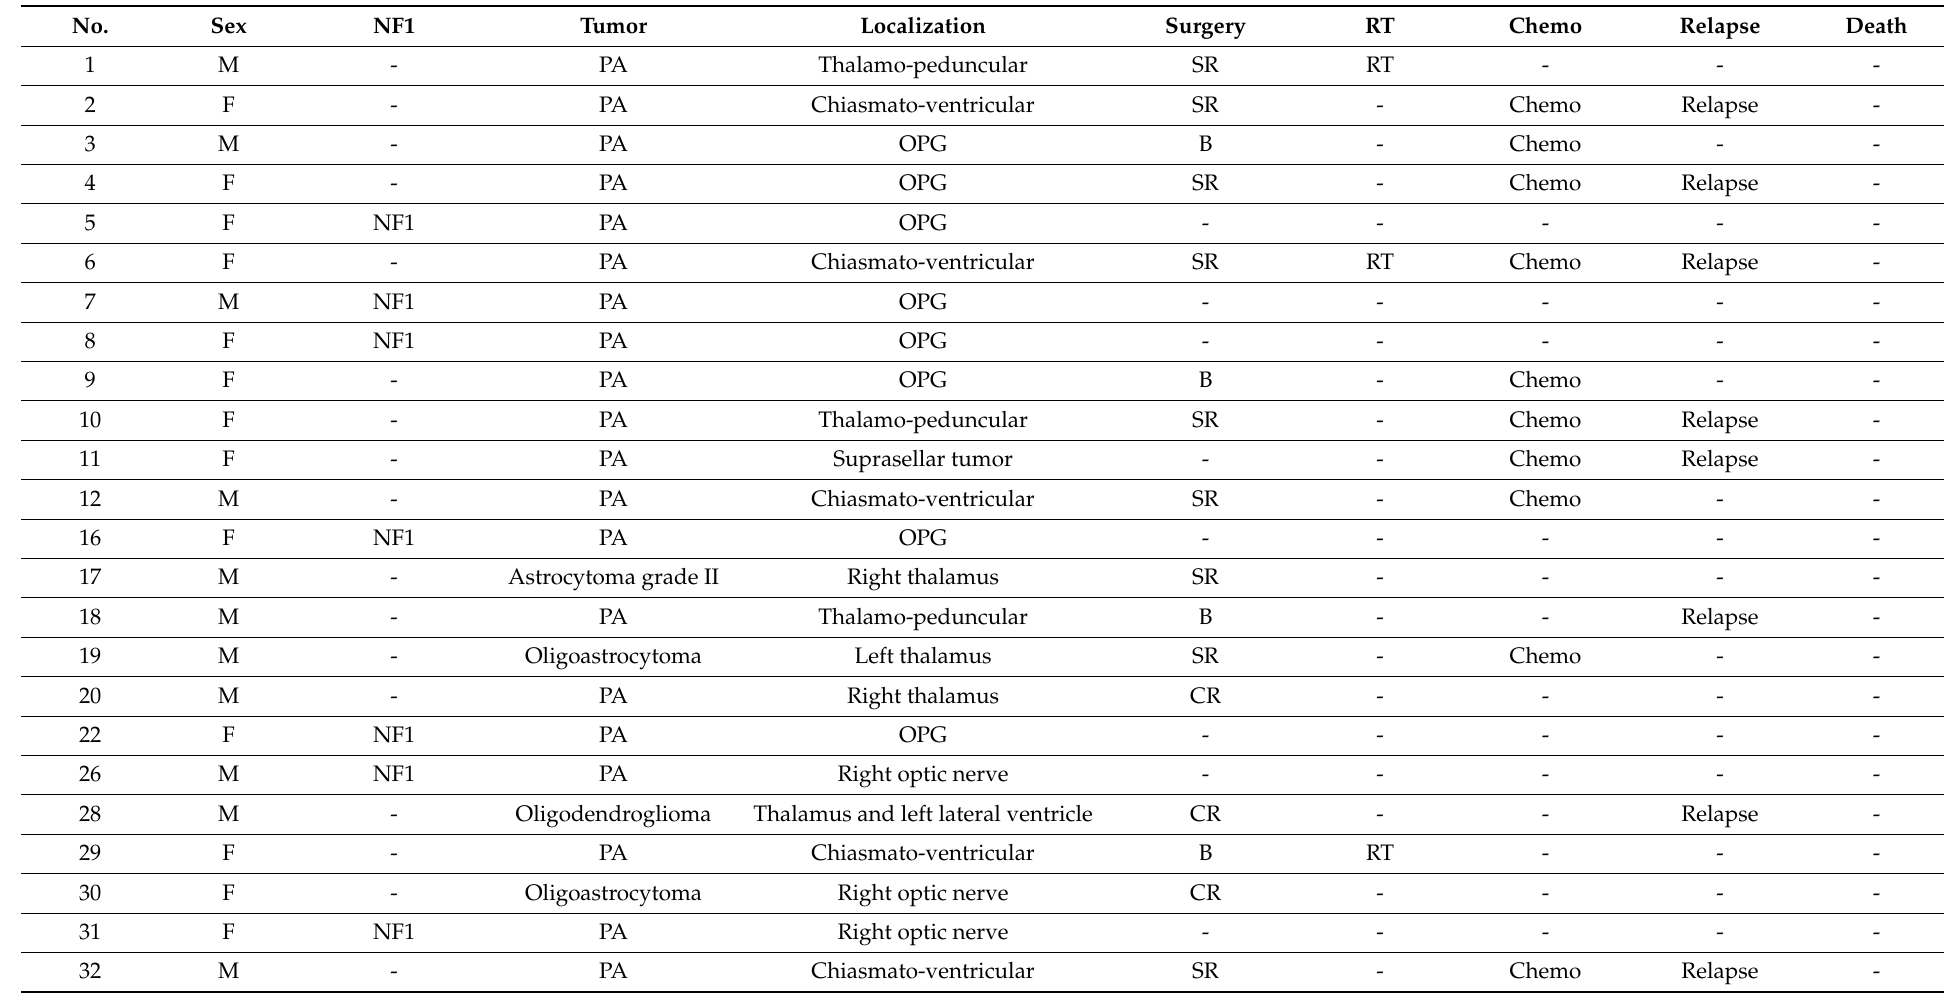
Table 3. Characteristics of patients without GH following a low-grade midline glial tumor between 1 January 1998 and 31 December 2016 at the Lille and Lyon